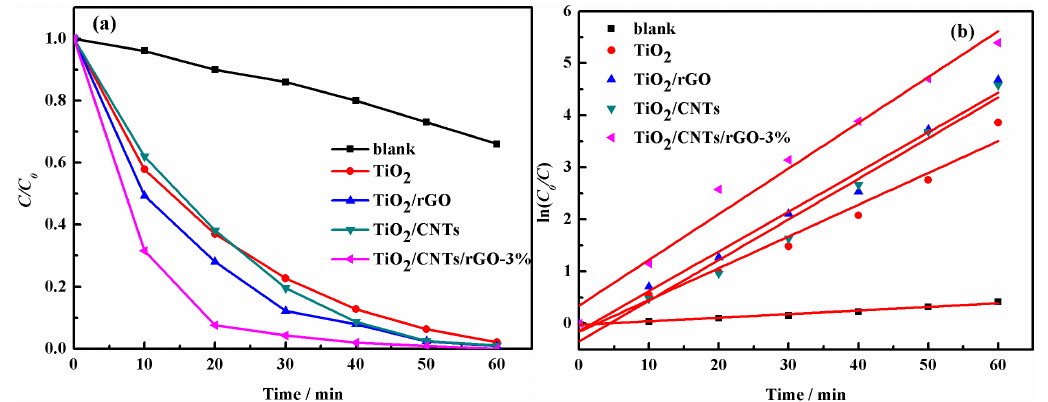
Figure 4. Blank test, TiO 2 , TiO 2 /rGO, TiO 2 /CNTs and TiO 2 /CNTs/rGO-3%: ( a ) plot of C / C 0 vs. irradiation time of RhB degradation; ( b ) linear transform ln( C 0 / C ) = kt of the kinetic curves of RhB degradation.